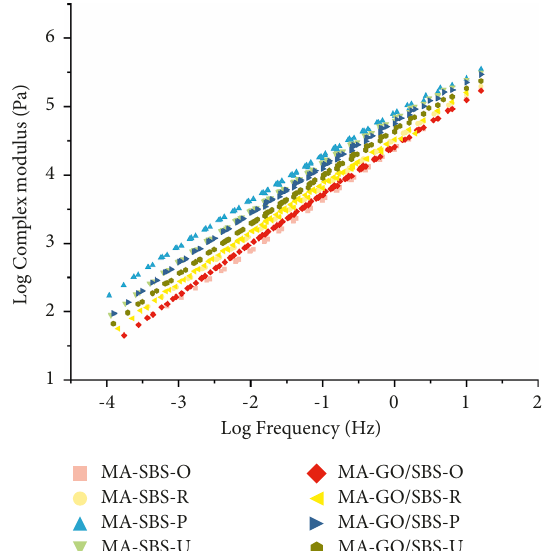
Figure 9: G ∗ master curves for MA-SBS and MA-GO/SBS at a reference temperature of 40 °